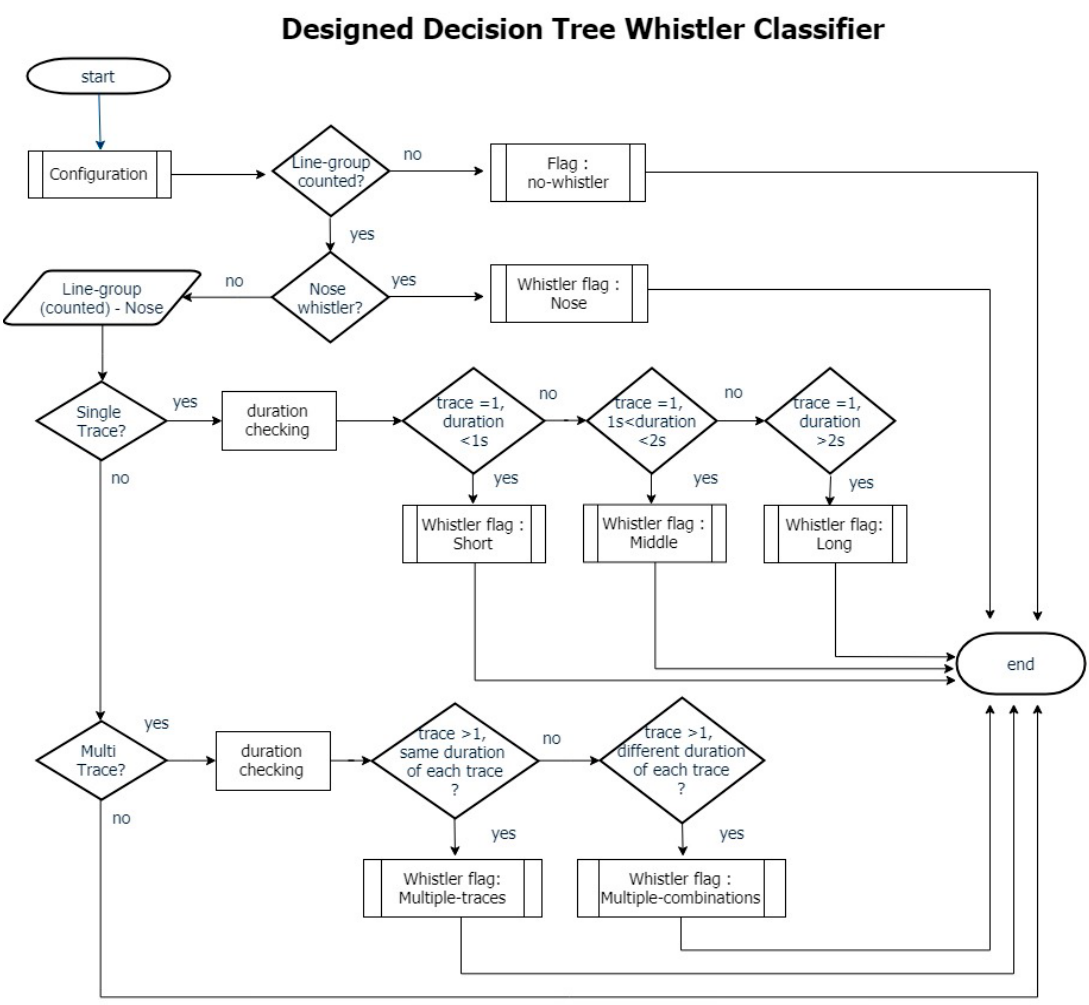
Figure 8. Decision tree for the all-whistler classifier. 320